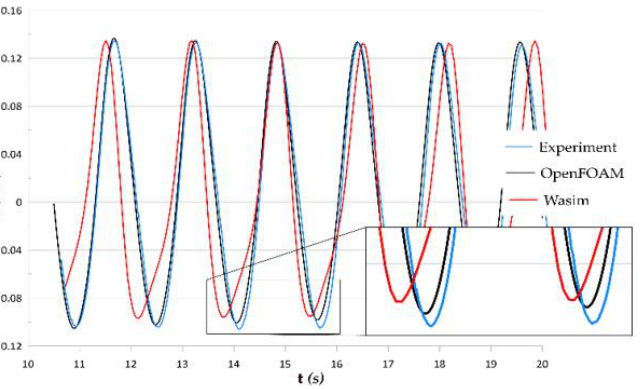
Figure 19. 6750 TEU containership in wave case 5. ( a ) Experiment photography; ( b ) OpenFOAM snapshot.